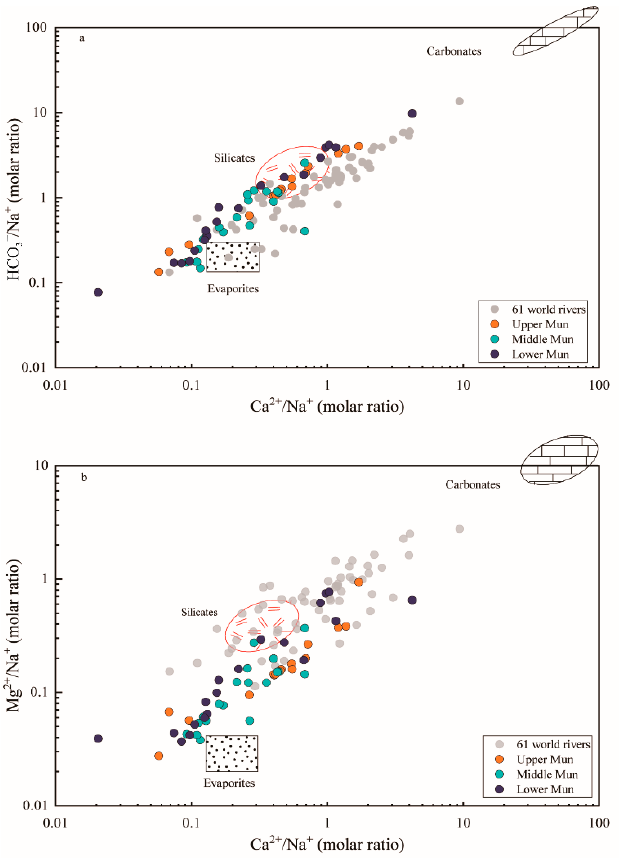
Figure 5. The elemental ratio of ( a ) HCO 3 − /Na + and ( b ) Mg 2+ /Na + versus Ca 2+ /Na + molar ratios of waters samples in the MRB and the world major rivers. The data of 61 large world rivers and three end-members were derived from [1].